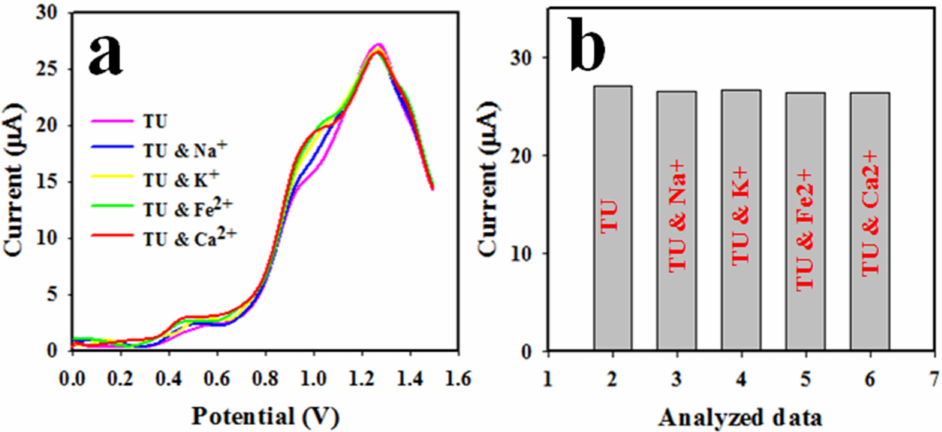
Figure 9. ( a ) The assessment of the interference effect of TU sensor in the presence of common electrolytes and ( b ) bar diagram of the interference